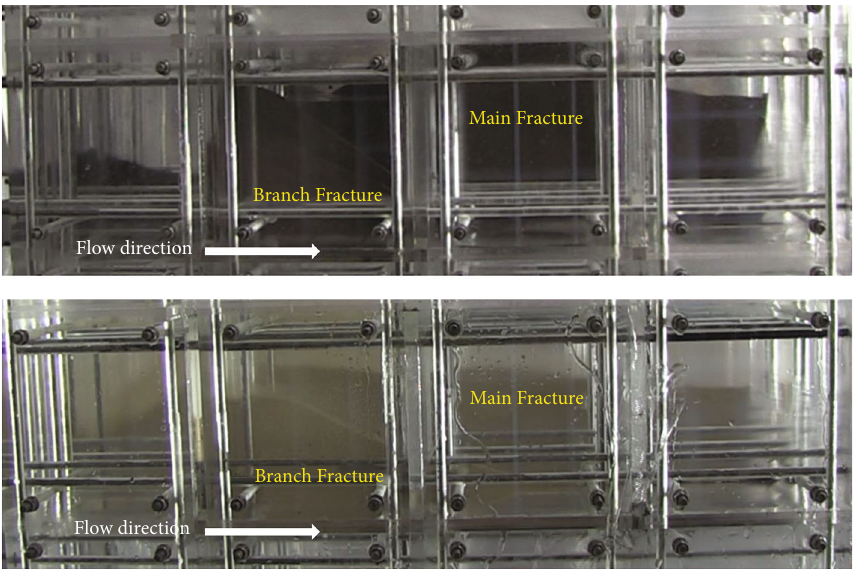
Figure 9: The di ff erent experimental results of proppant transport in complex fractures.